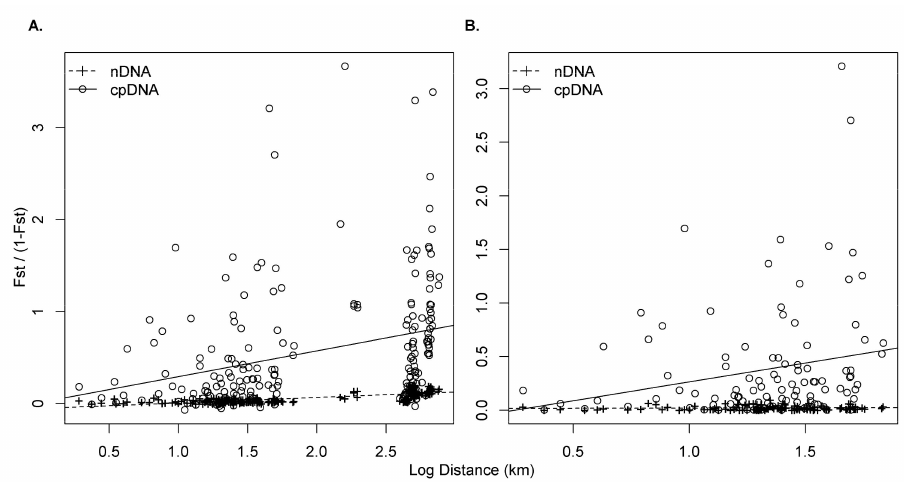
Figure 6. Comparative analysis of the isolation by distance according to the nuclear and plastid markers at two spatial scales: ( A ) Central Sahara (including the four massifs; 21 localities; cpDNA: r = 0.303, p = 0.01; nuclear SSRs (nDNA): r = 0.153, p = 0.01), and ( B ) Ahaggar (15 localities; cpDNA: r = 0.209, p = 0.10; nuclear SSRs (nDNA): r = 0.143, p = 0.17). F ST / (1 − F ST ) was plotted against the logarithm of geographic distance following Rousset [62].